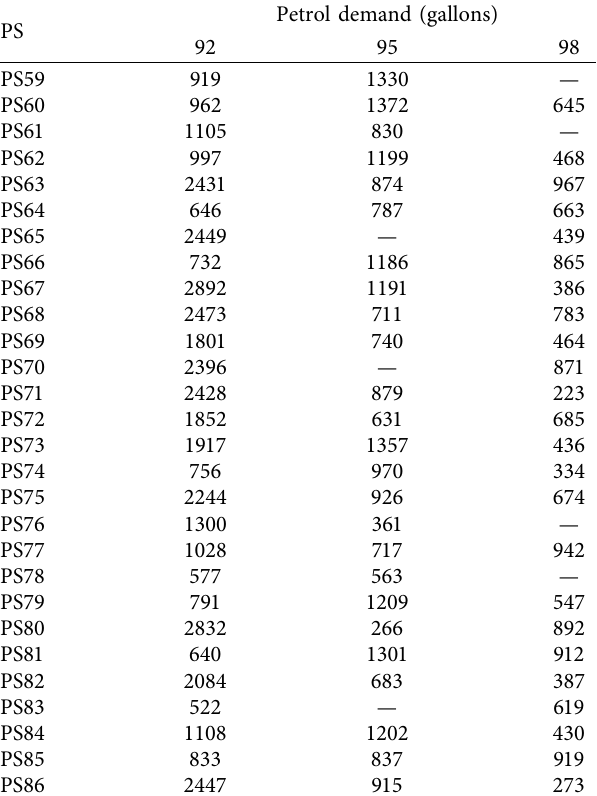
Table 8: Comparison between initial and optimized network over one working period (unit: